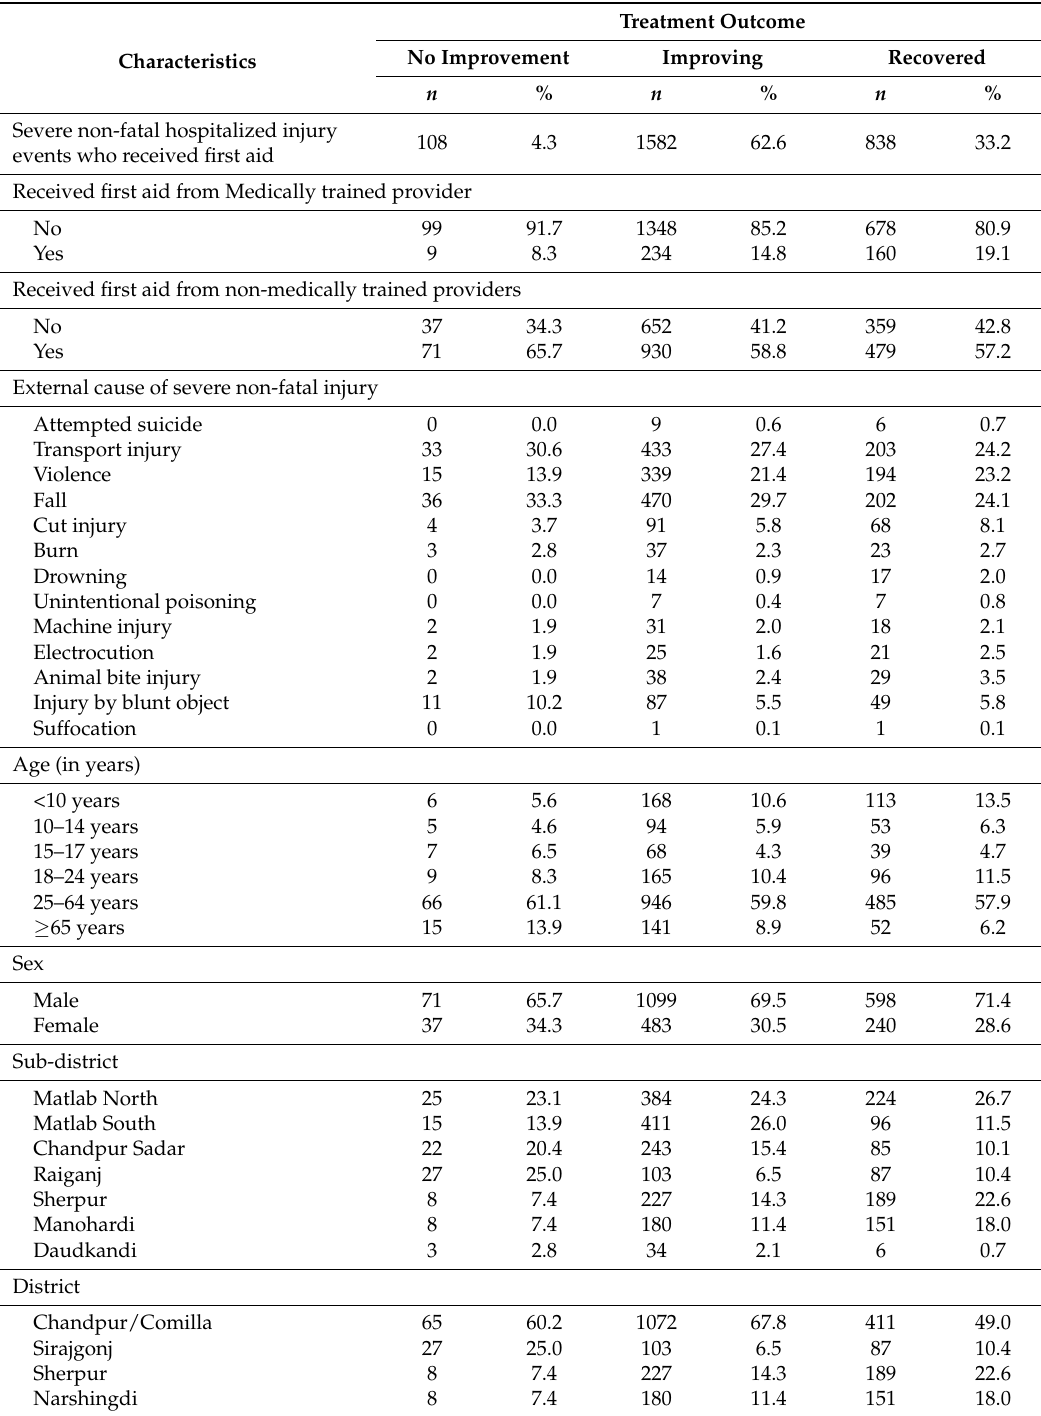
Table 5. The distribution of treatment outcomes by injury mechanism, socio-demographic and geographical factors among severe non-fatal hospitalized injury patients. Treatment Outcome No Improvement Improving Characteristics